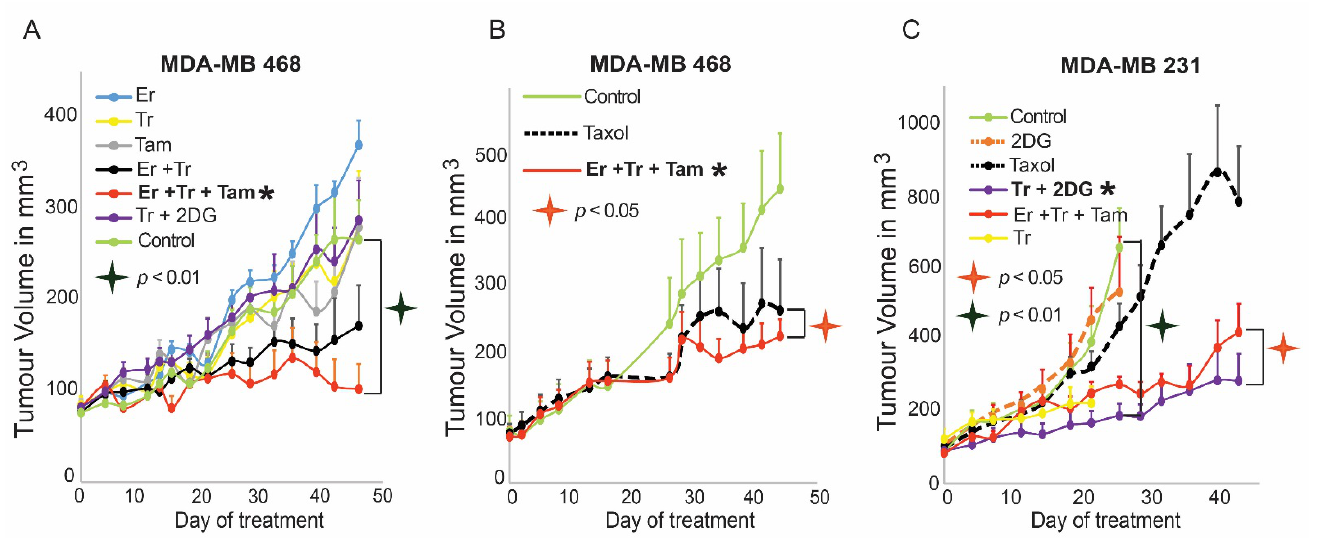
Figure 6. The PaSSS-based drug combinations stopped tumor growth in vivo. MDA-MB-468 ( A , B ) or MDA-MB-231; ( C ) cells were injected subcutaneously into mice, and once tumors reached 80 mm 3 , treatments were initiated. In both cases, the PaSSS-based drug combinations, predicted to collapse the cell line-specific altered signaling signature, inhibited the tumor growth and demonstrated an effect superior to monotherapies or combinations predicted to target partially the PaSSS (see Figure 2 for details regarding the altered signaling signatures and the PaSSS-based drug combinations). The values are mean ± S.E. for at least n = 8 for each condition. (Abbreviations: Er—Erlotinib, Tr—Trametinib, 2DG—2